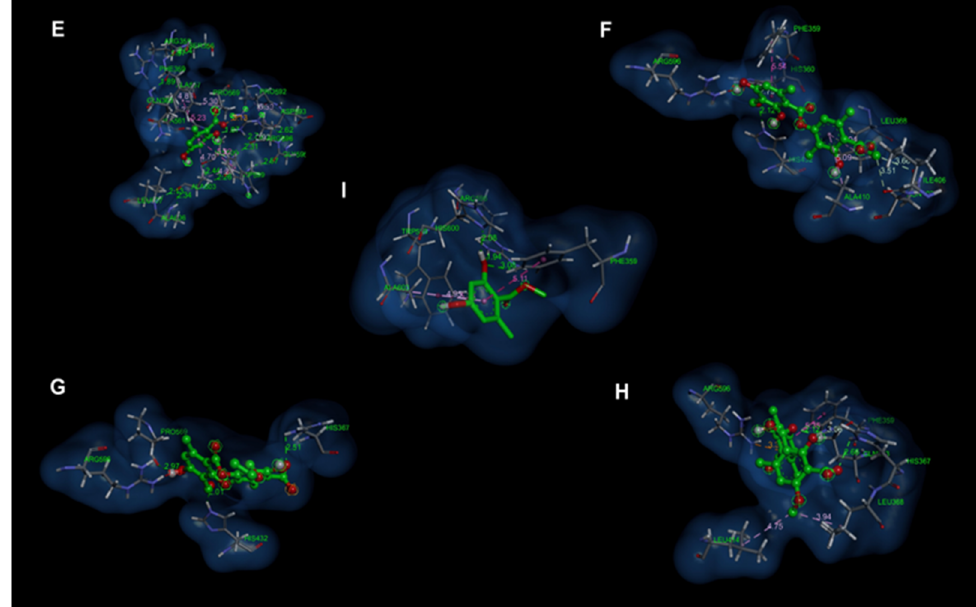
Figure 6 . Molecular docking of compounds present in the species of Cladonia . ( E ) Conformation of a higher affinity of orsellinic acid with 5-LOX; ( F ) Conformation of a higher affinity of atranorin with 5-LOX; ( G ) Conformation of a higher affinity of cetraric acid with 5-LOX; ( H ) Higher affinity conformation of squamatic acid with 5-LOX; ( I ) Higher affinity conformation of methylorsellinate with 5-LOX.